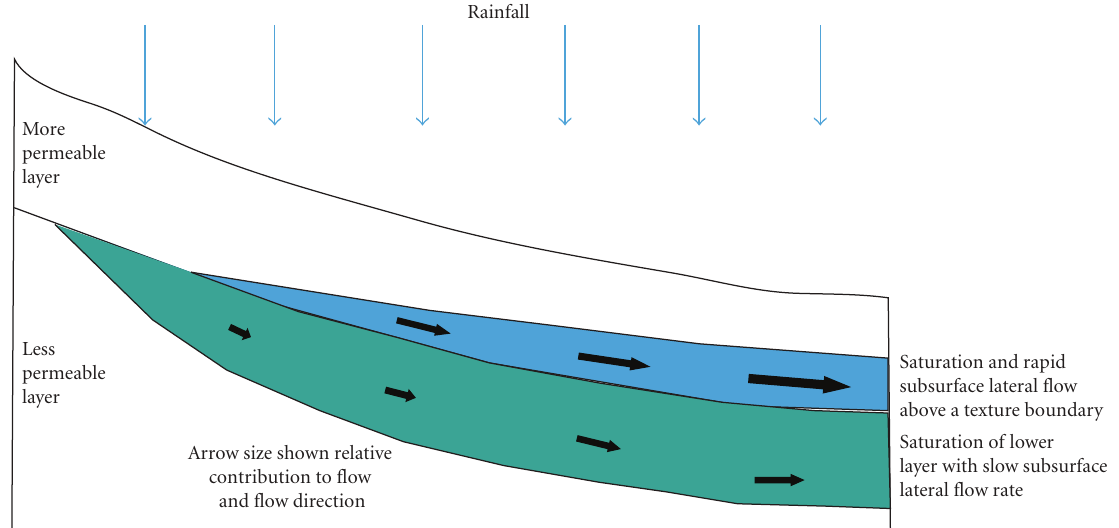
Figure 3: Conceptual model of subsurface flow in a texture-contrast soil (adapted from Whipkey and Kirkby [69]). Saturated layers and subsurface flow above and below the contact with an impeding layer, under conditions of steady rainfall.